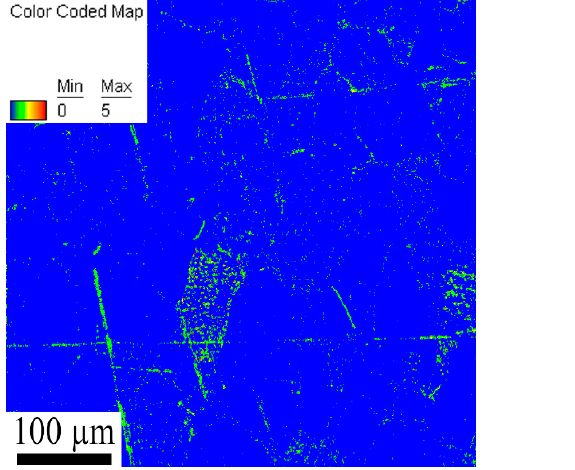
Figure 6. Microstructure of ARMCO iron after LSP: ( a ) SEM image, ( b ) EBSD IPF map and ( c ) TEM image; the bottom edge of the SEM image corresponds to the surface of the specimen.